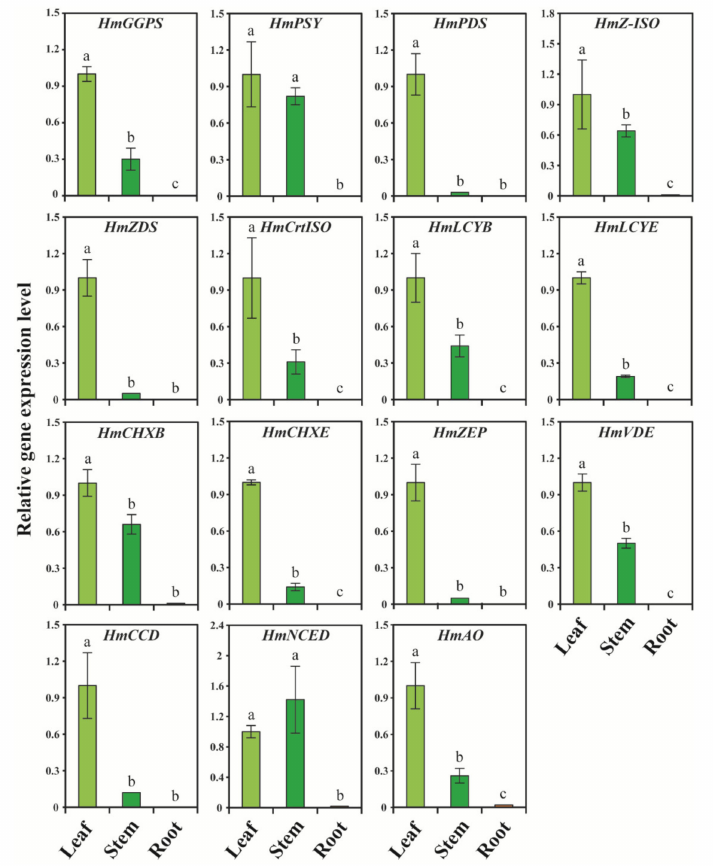
Figure 7. Relative gene expression level of 15 CP, XP, and AP genes of H. moellendorffii . Expression levels of CP, XP, and AP genes were analyzed in different parts such as leaf, stem, and root of H. moellendorffii using qRT-PCR. Transcriptional levels in leaves were set as a control (the value of 1) to calculate the relative gene expression in other tissues. The relative gene expression levels of CP, XP, and AP genes were normalized to α -tubulin as a reference gene. Results are given as the means of three replicates ± standard deviation. Different alphabetical letters a–c denote significant differences ( p <